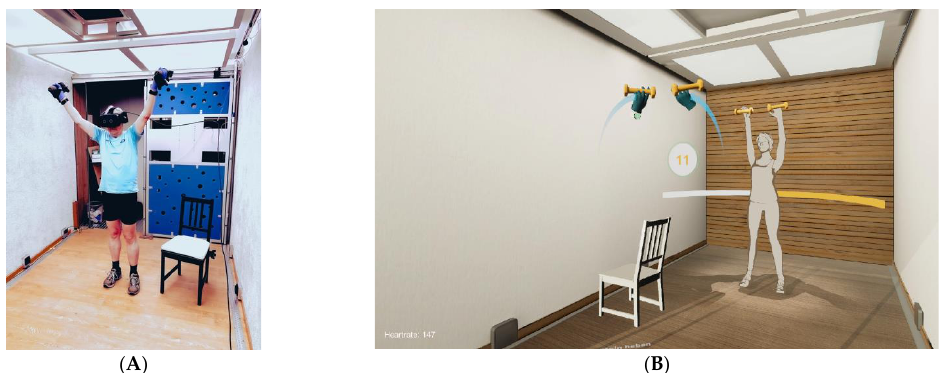
Figure 2. ( A ) Participant in the VITALab.Mobile with the real training objects: chair and dumbbells; ( B ) recreated interior of the VITALab.Mobile in VR with the virtual equivalents of the training objects and the virtual trainer agent Anna. Both images ( A , B ) were taken independently of each other at different times; thus, e.g., the chair is not in exactly the same position in the images, which, however, was, the case during the test.